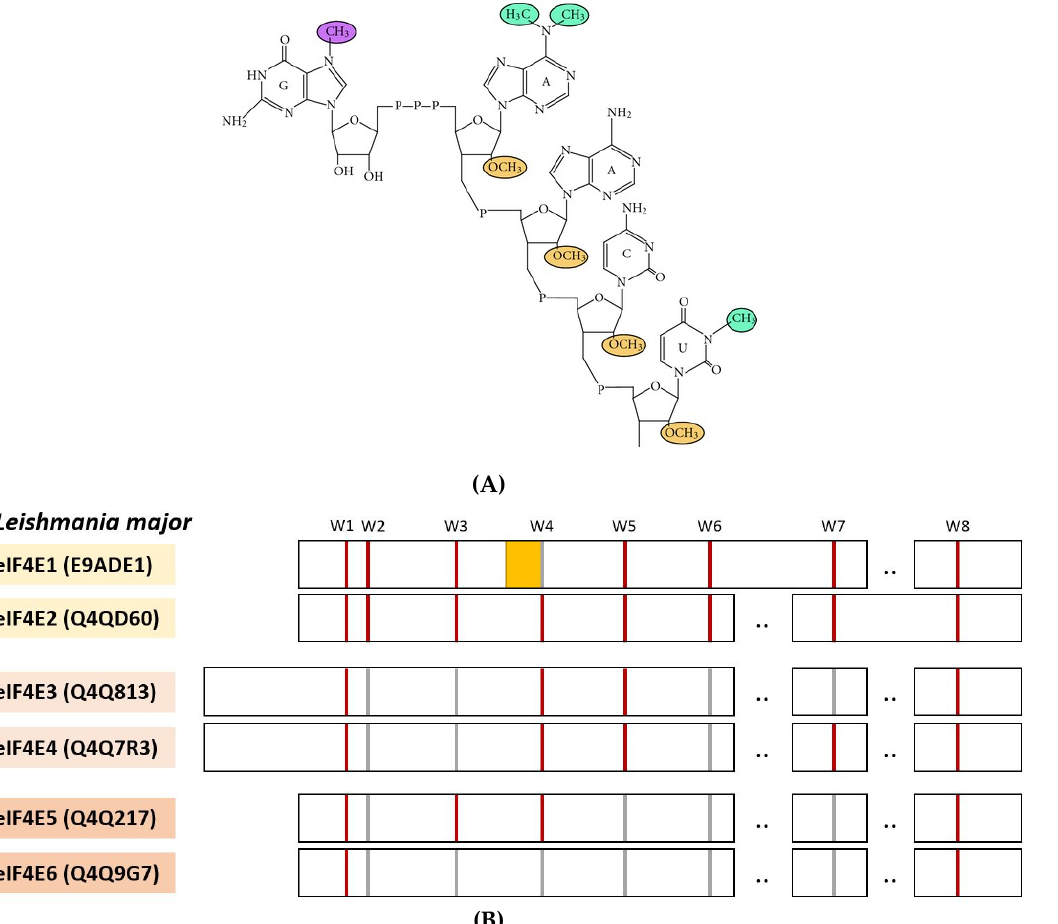
Figure 4. ( A ) Chemical representation of cap4-structure from Trypanosomatids (taken from Zinoviev and Shapira [81]). ( B ) Scheme representing the core of Leishmania major eIF4E1 to eIF4E6 (accession numbers in brackets) including the eight conserved tryptophane residues W1 to W8 (highlighted in red), substitutions of W2, W3, W4, W5, W6, or W7 for Y, F, or L are labelled in grey. Highlighted yellow is the conserved helix-forming motif S/TVxxF next to W4 of Leishmania eIF4E1. At least 6 different eIF4E (see Figure 4B) and 5 eIF4G paralog genes have been identified for